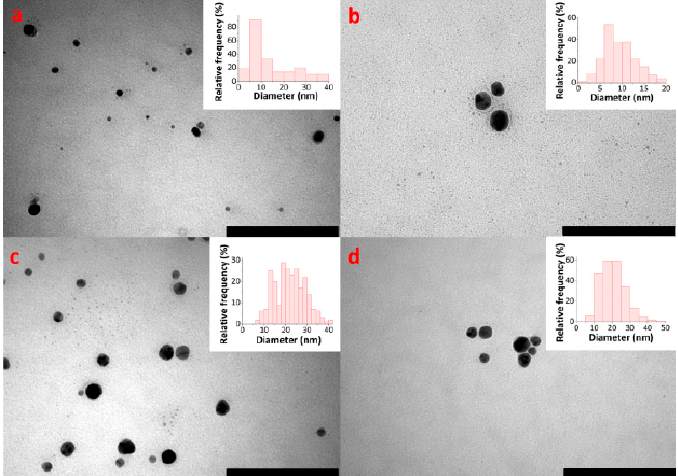
Figure 7. TEM micrographs and distribution of the nanoparticles for the nanocomposites of A with the different silver ratios ( 1 ) ( a ) (208 NPs), ( 2 ) ( b ) (211 NPs), ( 3 ) ( c ) (246 NPs), and ( 4 ) ( d ) (226 NPs). The scale bar is 200 nm.